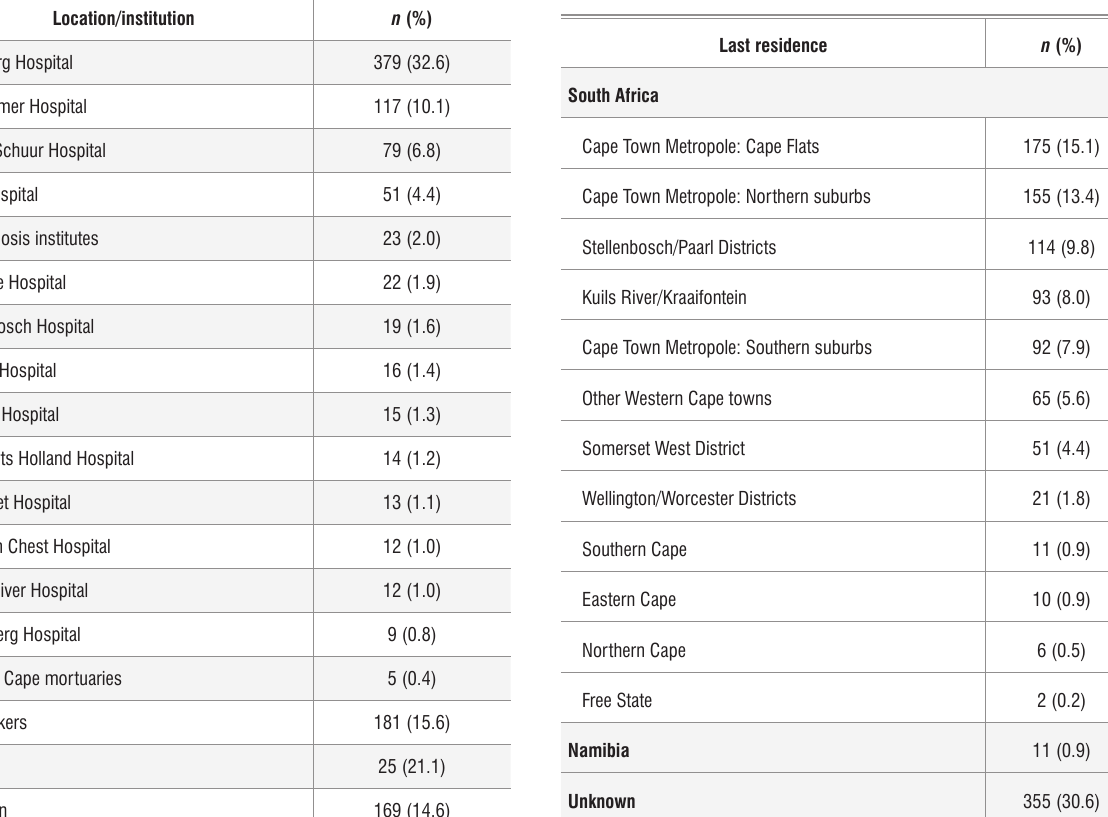
Locations or institutions from which bodies were received Last available residence (region) of individuals in the Kirsten